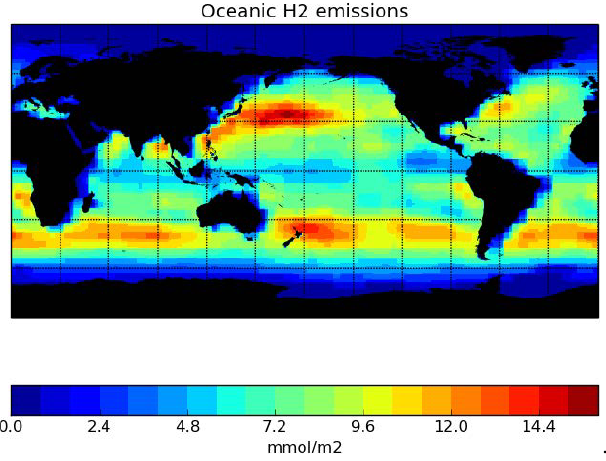
Figure 8. Oceanic H 2 emissions used in the TM5 model simulations (mmolm − 2 a − 1 , based on the distribution provided by the project GEMS (Global and regional Earth-system (atmosphere) Monitoring using Satellite and in-situ data) and scaled to a total oceanic source of 5Tga − 1 (Pieterse et al.,